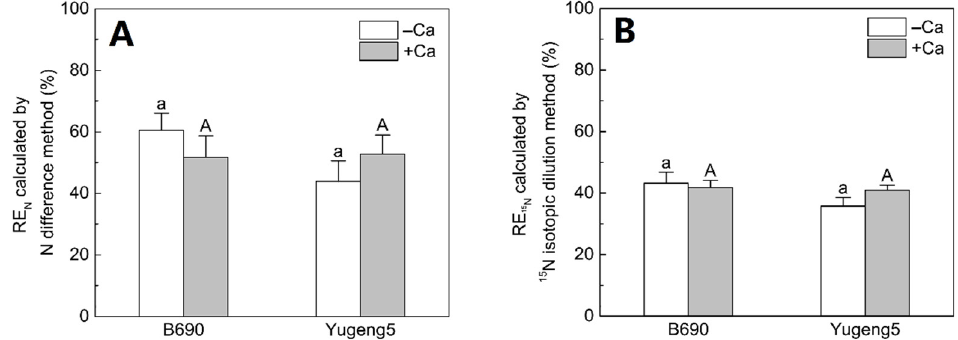
Figure 8. Effect of liming on fertilizer nitrogen (N) recovery efficiency (FNRE) of the two rice cultivars ‘B690 ′ and ‘Yugeng5 ′ . ( A ), FNRE calculated by N difference method; ( B ), FNRE calculated